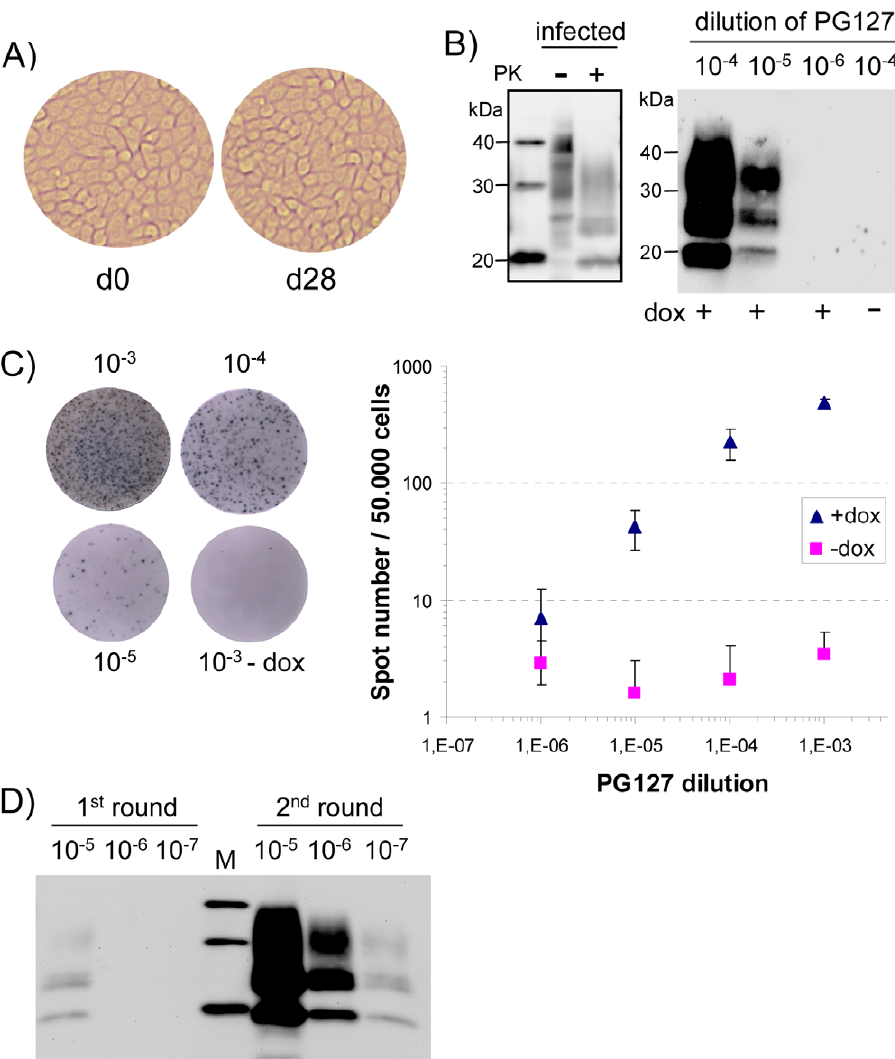
Figure 1. Sensitivity of ovRK13 cell assay for the detection of PG127 ovine prion. A) Morphology of inoculated ovRK13 cultures kept in the same wells during the whole cell assay procedure (d0 is the time of inoculation and d28 is 4 weeks later). B) Sensitivity of ovRK13 cell assay as assessed by immunoblotting. Right panel: Serial 10-fold dilutions (from 10 2 4 to 10 2 6 ) of infectious PG127 10% brain homogenate were inoculated to single wells of ovRK13 cells. Four weeks later, inoculated cultures were analyzed for PrP res by immunoblotting. Positive transmission was detected for dilutions up to 10 2 5 . No PrP res was observed when inoculated ovRK13 did not express the ovine PrP (dox-). Left panel: total PrP from infected cells was analyzed before ( 2 ) or after ( + ) PK digestion to illustrate band shift upon PK proteolysis. M are standard molecular mass marker proteins (20, 30 and 40 kDa). C) Sensitivity of ovRK13 cell assay as assessed by Elispot. Replicate wells from the same experiment shown in Fig. 1B were analyzed. Left: representative wells of an Elispot plate showing spots given by ovRK13 cells exposed to the indicated dilutions of PG127. Right: double-logarithmic plot of spot number versus PG127 dilution shown for inoculations in the presence (triangle) or in the absence (square) of dox. For each dilution, the mean value 6 SD of 8 measurements is shown. Background values for ovRK13 cells inoculated in the absence of dox are less than 4 spots per 50,000 cells. D) Sensitivity is strongly improved by 2 successive rounds of cell assay. Serial 10-fold dilutions (from 10 2 5 to 10 2 7 ) of infectious PG127 10% brain homogenate were inoculated to duplicate wells of ovRK13 cells. Four weeks later, PrP res in a 1 st set of inoculated cultures was isolated (1 st round) while cultures of the 2 nd set were homogenized to inoculate new ovRK13 cells. Four weeks later, PrP res was isolated (2 nd round) and all the samples were analyzed by immunoblotting. M are standard molecular mass marker proteins (20, 30 and 40